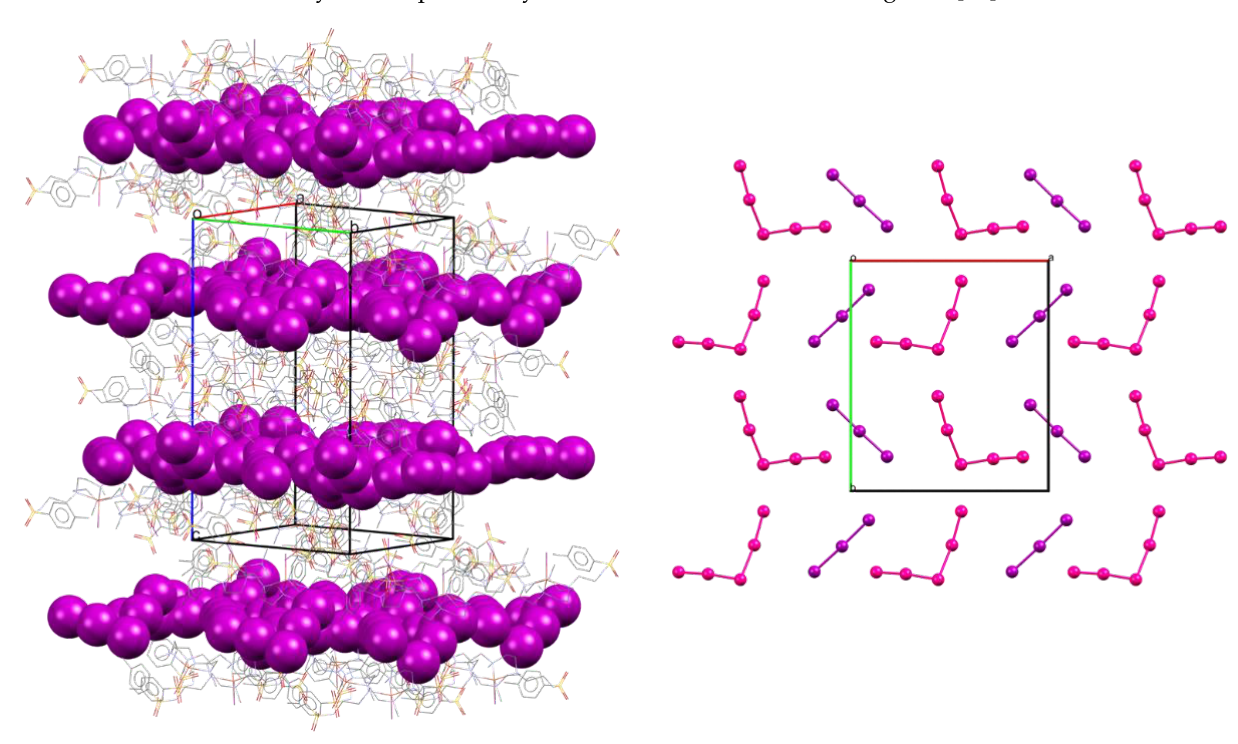
Figure 8. Left: alternated planes of polyiodides and H-bonded [Cu(L)I] + complexes developing perpendicular to the c-axis direction. Right: breakdown of polyiodide motif viewed along the c-direc- tion.